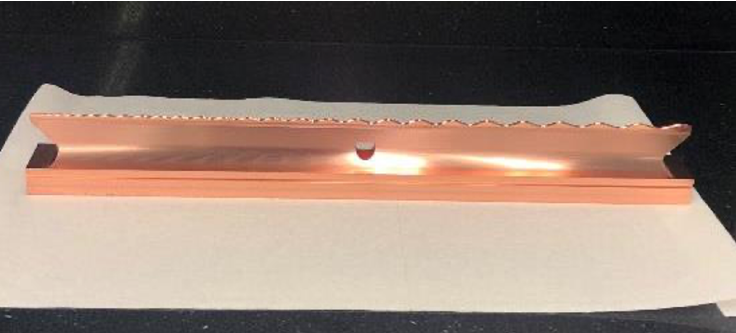
Figure 6. Minor vane inside the RFQ cold model clearly showing the dummy